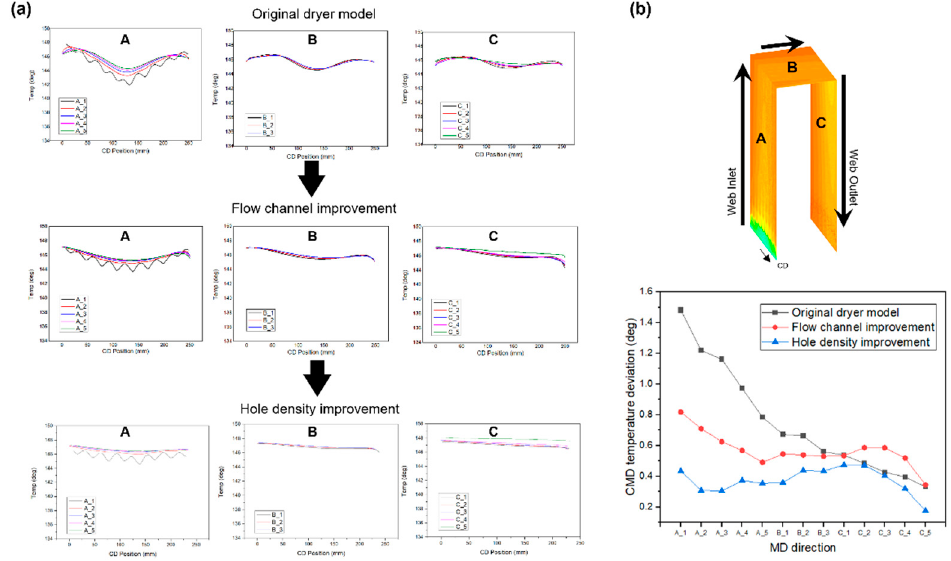
Figure 13. Comparison of ( a ) various dryer models and ( b ) the CMD temperature deviation at Regions A, B, and C.